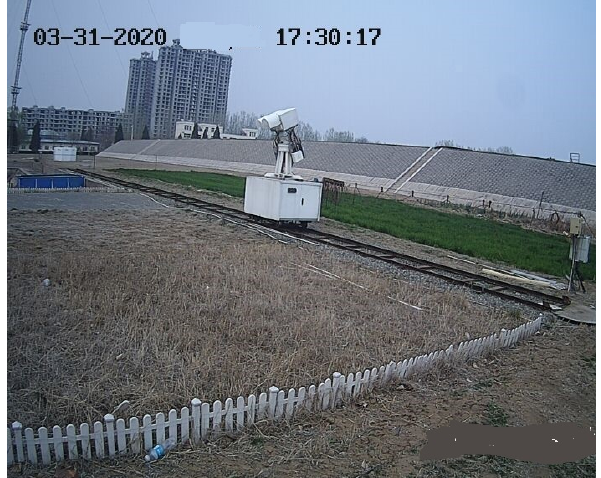
Figure 1. On-site photo of the surface microwave emissivity obser- vation system operating over various surfaces at the Xianghe site,